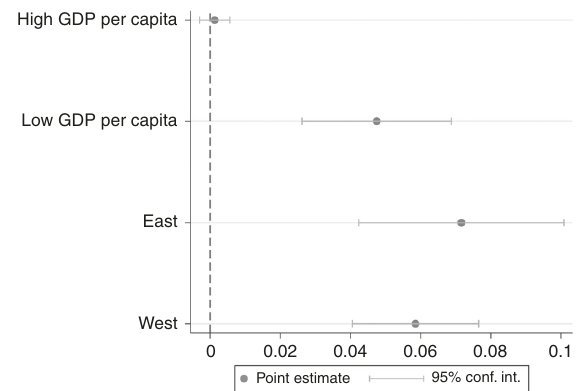
Fig. 2 Treatment effect estimates by region and economic condition. Rich counties are those areas with higher income, which tends to correlate with higher marketization levels. Moreover, rich regions are also characterized by effective data and information sharing, as well as cross-sectoral connectivity that extends to farmers and the agricultural sector. The eastern region includes Liaoning, Beijing, Tianjin, Hebei, Shandong, Jiangsu, Shanghai, Zhejiang, Guangdong, Fujian, and Hainan Provinces. The western region includes Xinjiang, Gansu, Qinghai, Inner Mongolia, Ningxia, Shaanxi, Sichuan, Chongqing, Guizhou, Yunnan, and Guangxi Provinces. Source data are provided in the Source Data fi le.